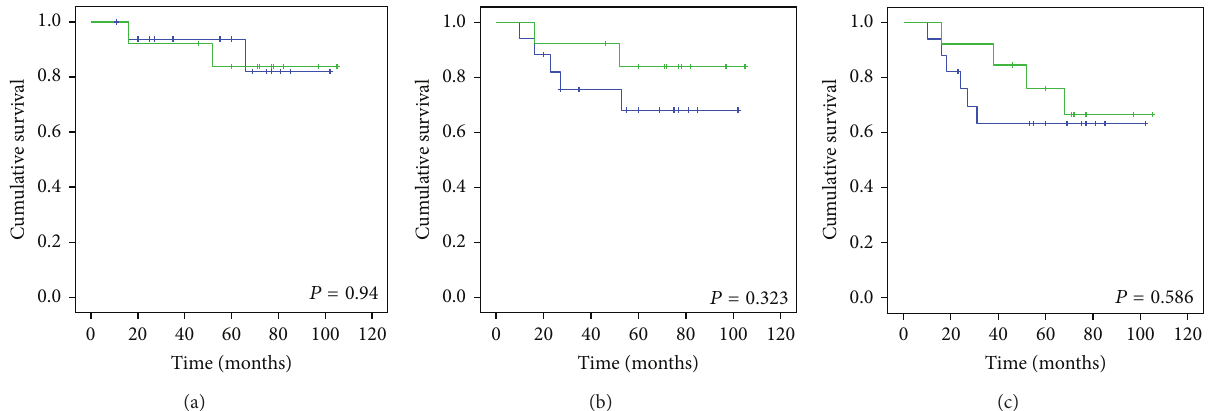
Figure 4: Comparison of (a) the 5-year overall survival, (b) the 5-year locoregional-free survival, and (c) the 5-year disease-free survival in the IMRT group with cranial nerve involvement (green line) or without cranial nerve involvement (blue